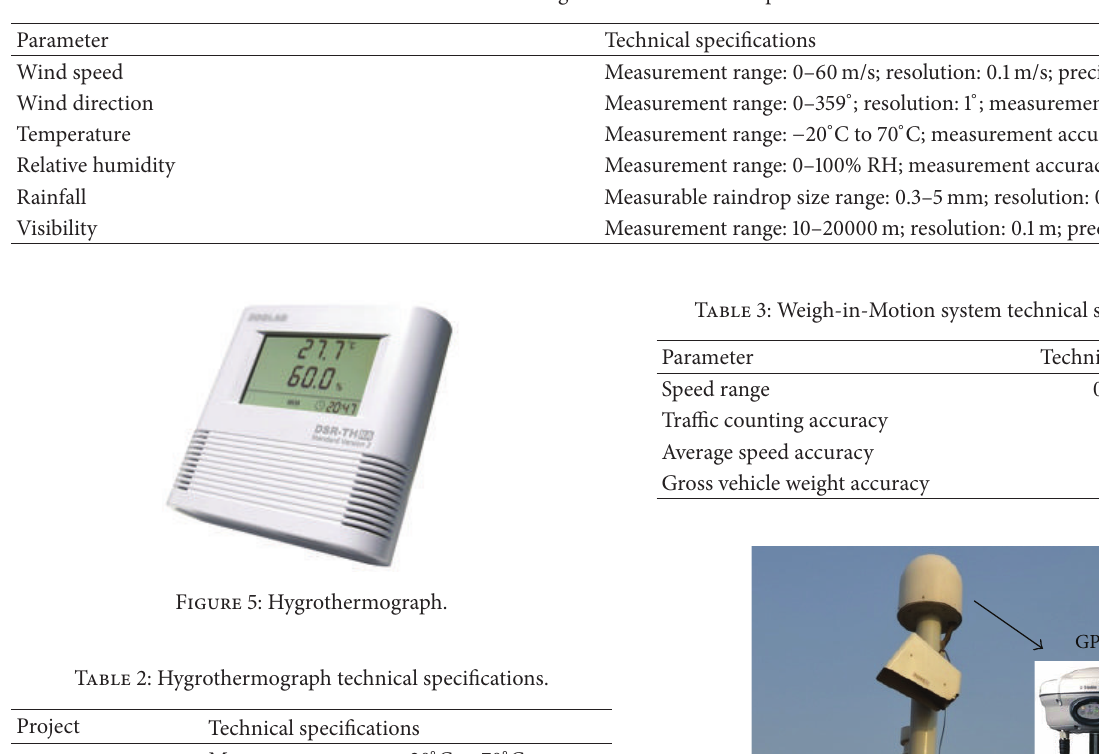
Table 1: Meteorological station technical specifications.